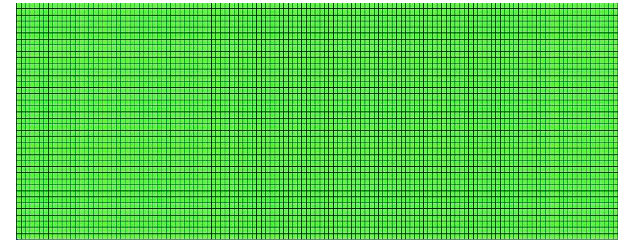
Figure 5. Schematic of the part of the grid.